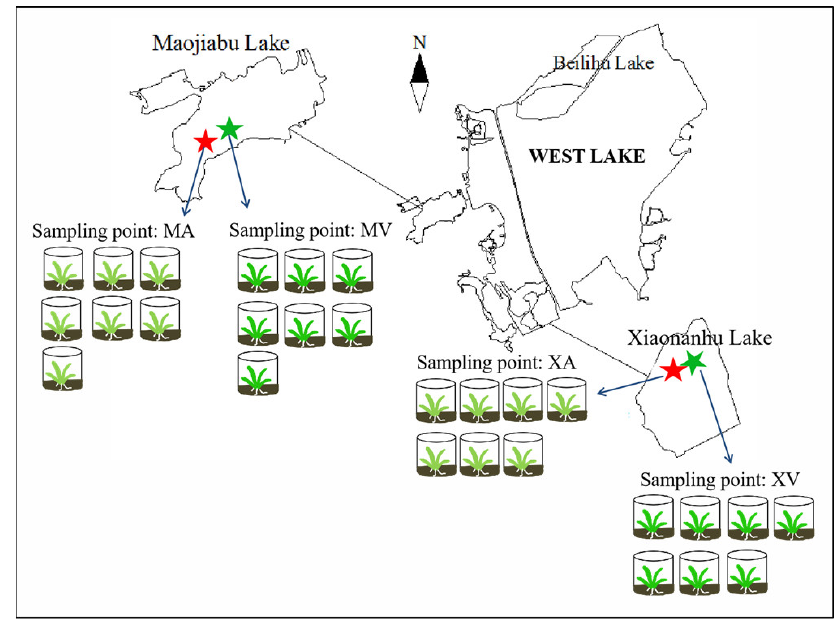
Figure 1. The experiment sampling sites in Maojiabu Lake and Xiaonanhu Lake.